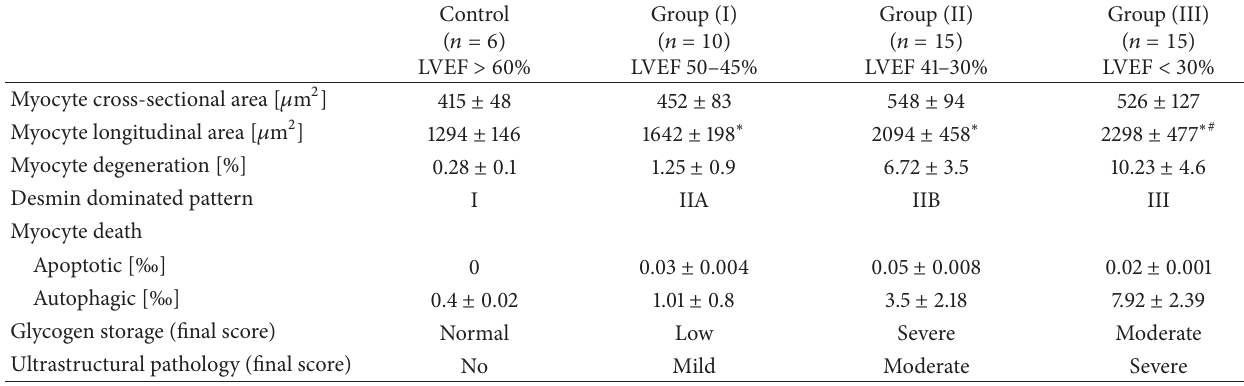
Table 3: Morphometric